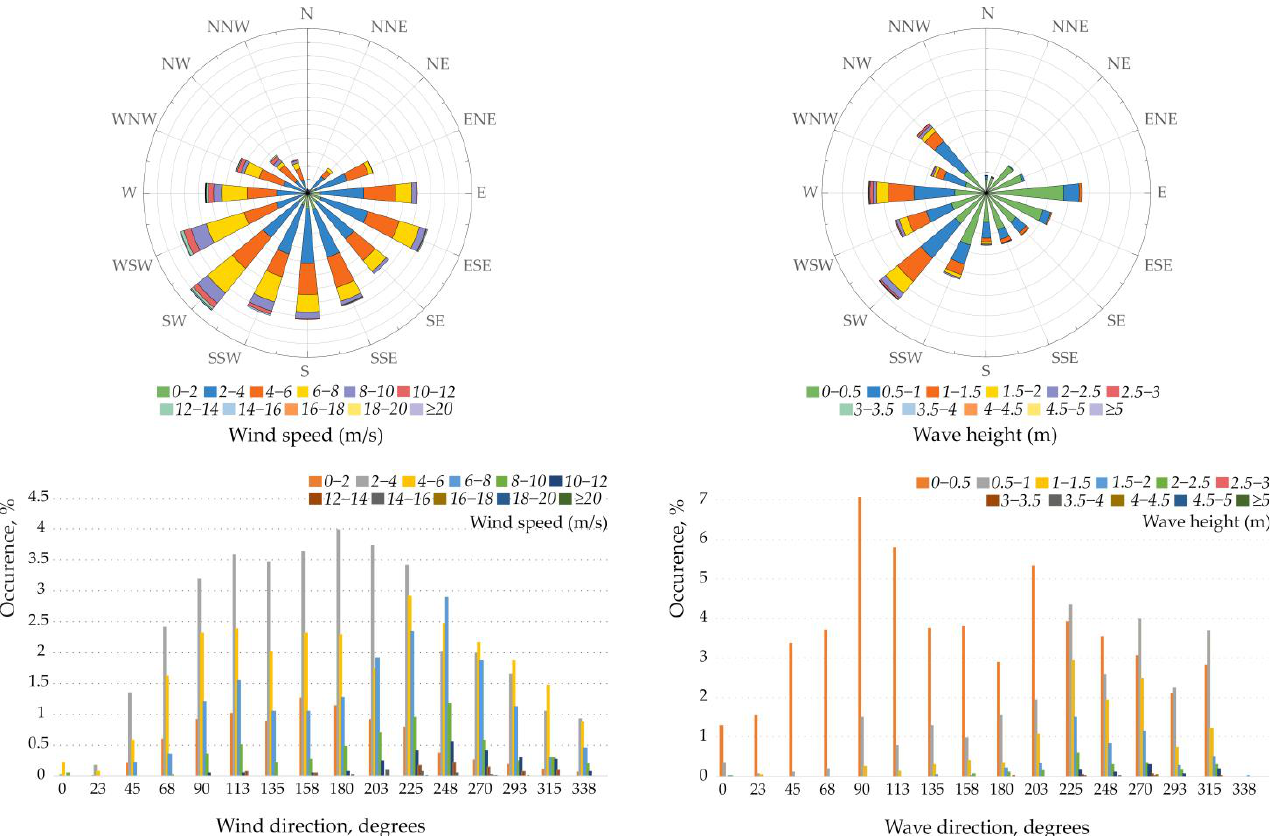
Figure 6. The wind rose diagram for wind direction and speed (m/s) from 1993 to 2003, a wave rose diagram for wave direction and mean wave height (m) from 1993 to 2003, the frequency distribution of wind speed (m/s) from 1993 to 2003, and frequency distribution of waves height (m) from 1993 to 2003.